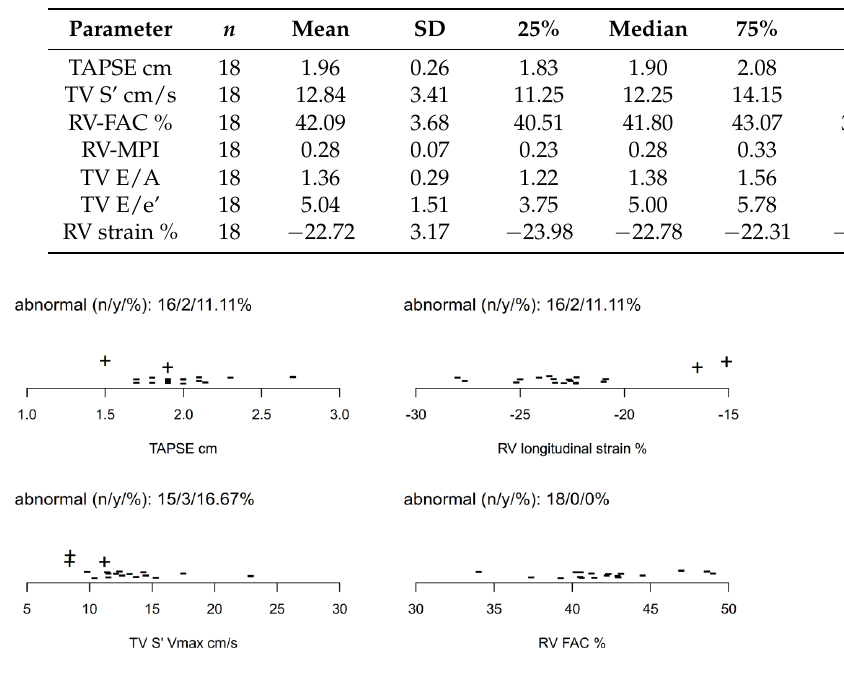
Figure 4. Distribution of raw data for TAPSE, RV longitudinal strain, TV S’, RV -FAC, RV MPI, TV E/A, TV E/e’, and TV e’/a’ . “−“ = parameter within age-dependent reference range; “+” = parameter outside of age- dependent reference range (“abnormal”) . 3.3. Effects of Patients’ Ag e on Right Ventricular Function With growing age, the proportion of patients without abnormal RV function de- creases (Figure 5a – e).